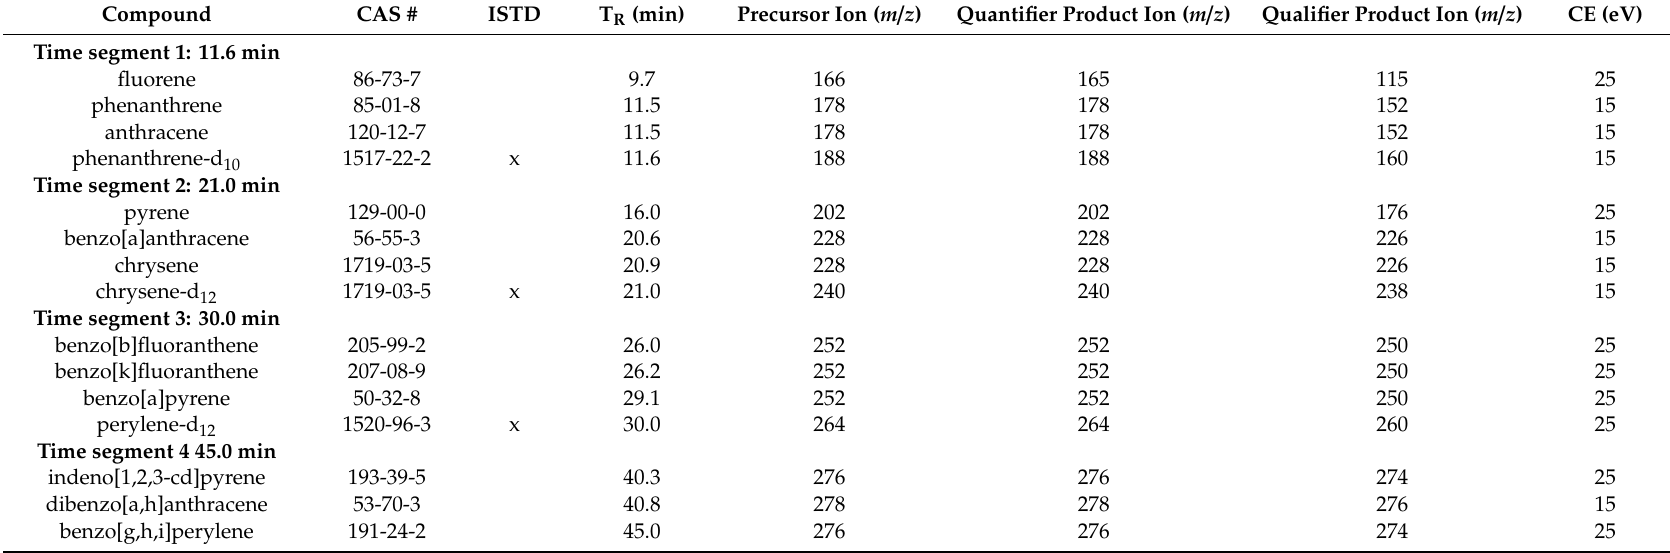
Table 1. List of PAHs and ISTD. MRM acquisition parameters: time segments, retention times (T R , min), precursor ions, quantifier and qualifier ions, collision energy (CE, eV). CAS numbers are also provided.